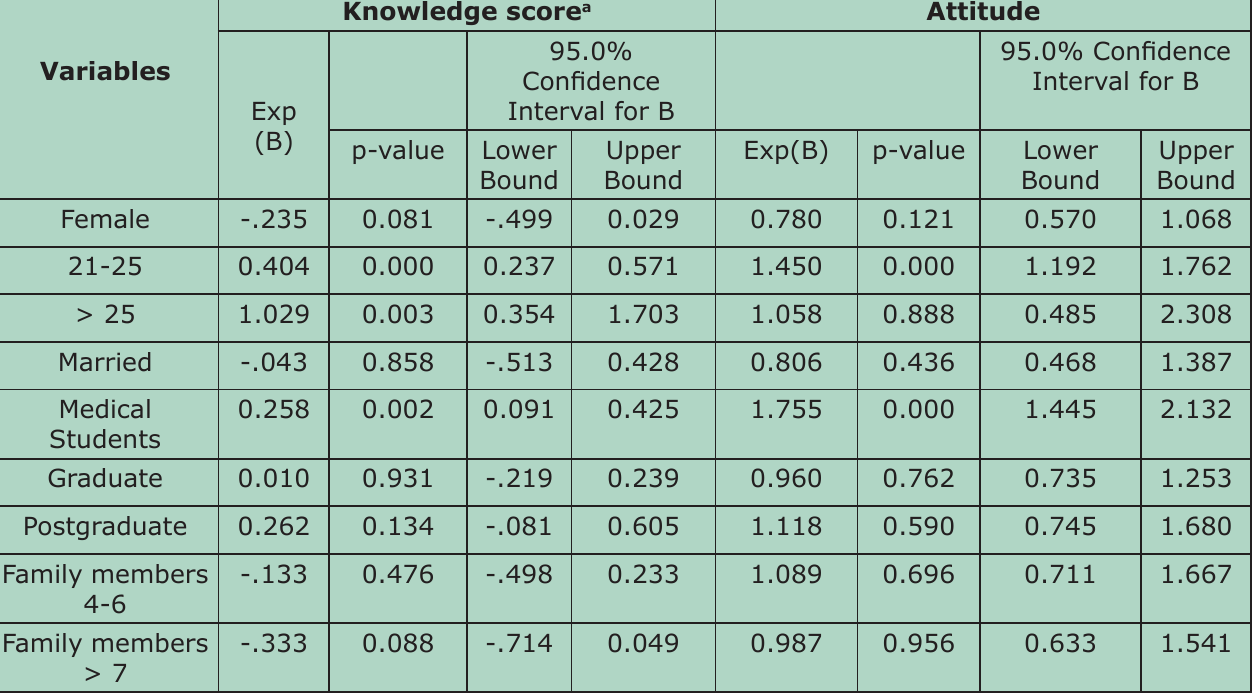
Table-V: Linear analysis with knowledge score and logistic regression analysis of attitude with different